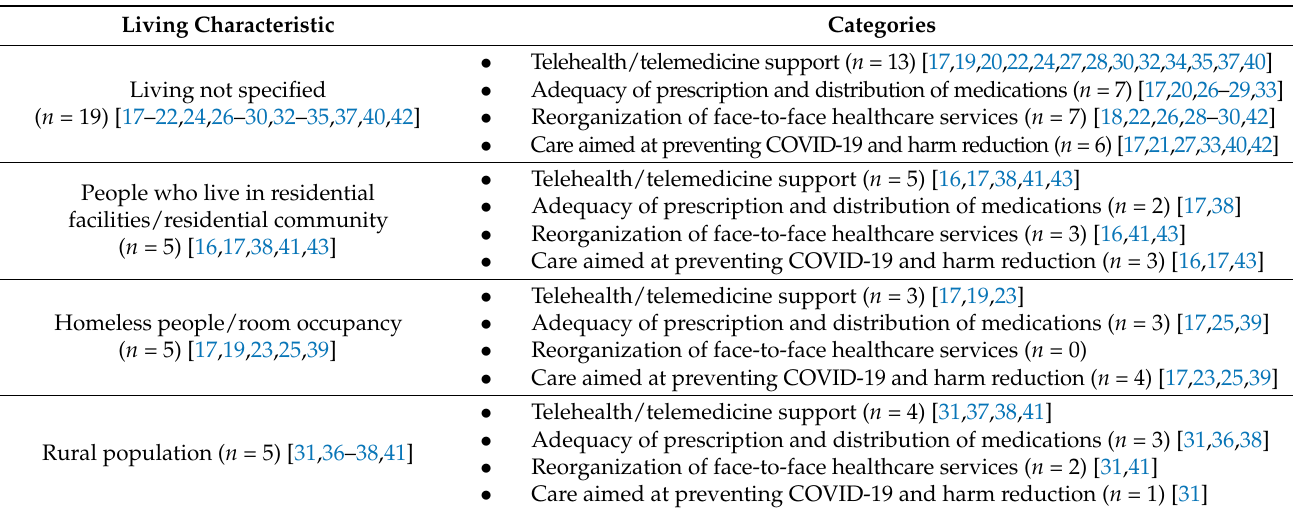
Table 3. Sample distribution according to category, number of studies, and living characteristics of the assisted population by the services and intervention categories. Brazil, 2021 ( n =